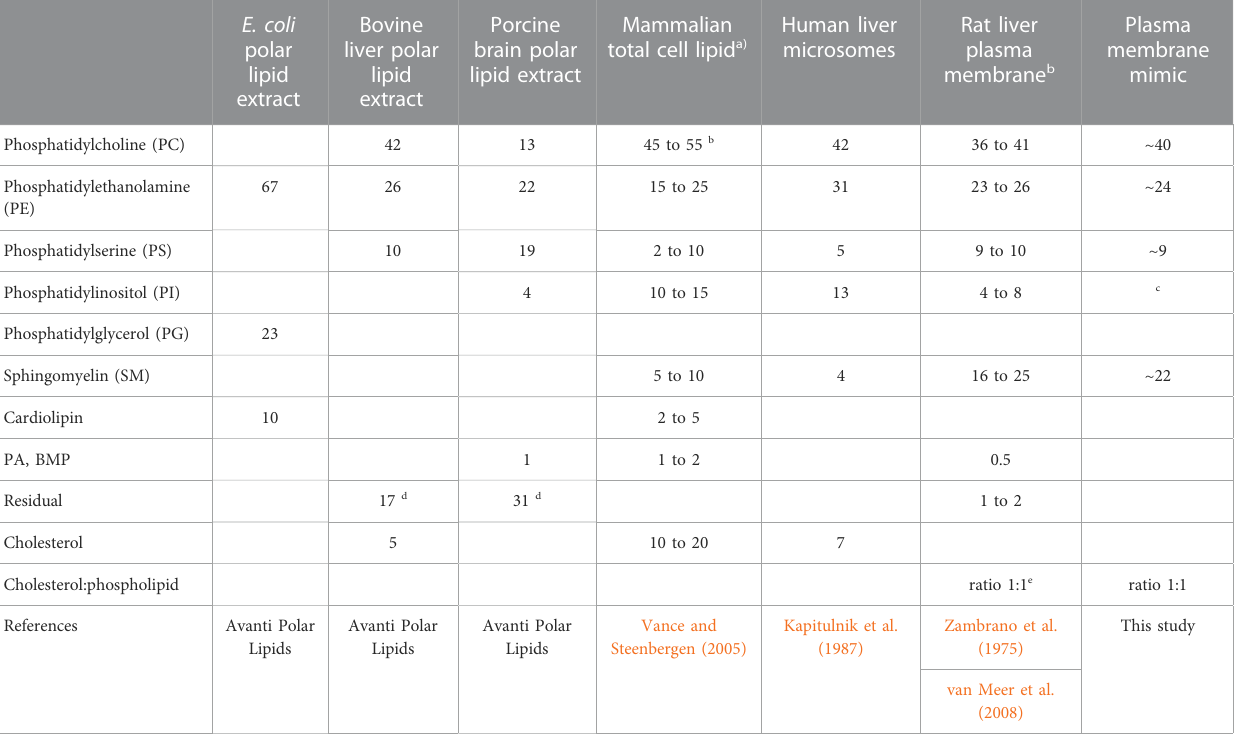
TABLE 1 Lipid composition of native mammalian